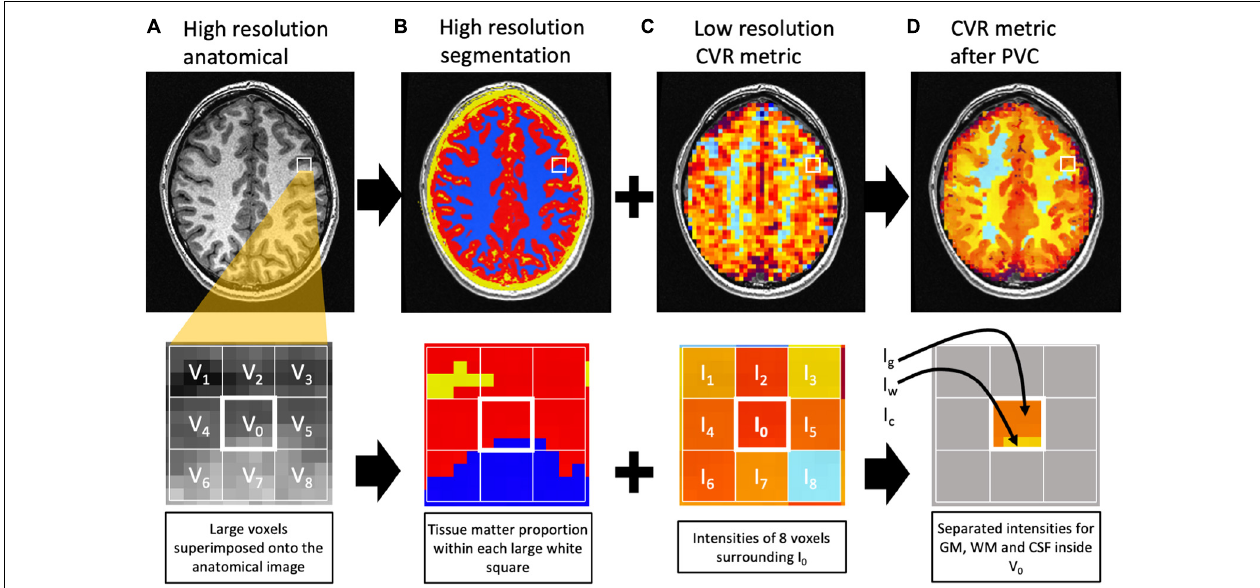
FIGURE 2 | Diagram representing the partial volume correction algorithm. The top row represents one slice of the brain, with a closeup on the second row. The high-resolution anatomical image (A) is used for segmentation (B) of GM (red), WM (blue), and CSF (yellow). Within the large voxels of the low-resolution image [white grid in (C) ], the proportion of each tissue matter can be calculated [ (B) , second row]. For example, voxel V 0 contains 81% gray matter (g 0 ), 19% white matter (w 0 ), and 0% CSF (c 0 ). The intensity I 0 in V 0 is an average of the intensities of GM (I g ), WM (I w ), and CSF (I c ) weighted by their respective matter proportion. The corresponding equation would be I 0 = g 0 I g + w 0 I w + c 0 I c . Under the assumption that each matter intensity (I g , I w , and I c ) is constant within a group of voxels surrounding V 0 , 8 similar equations can be written for V 1 , V 2 , ... , V 8 to solve for I g , I w , and I c inside V 0 . I g , I w , and I c are then assigned to the corresponding tissue matter inside V 0 (D) . Notes that voxels surrounding the central one but outside the BOLD mask are excluded from the regression. In this example, the solution I c is not assigned since there is no CSF inside V 0 . For this example, only 8 voxels surround V 0 . In the actual image analysis, the surrounding voxels were all voxels within a 9 mm